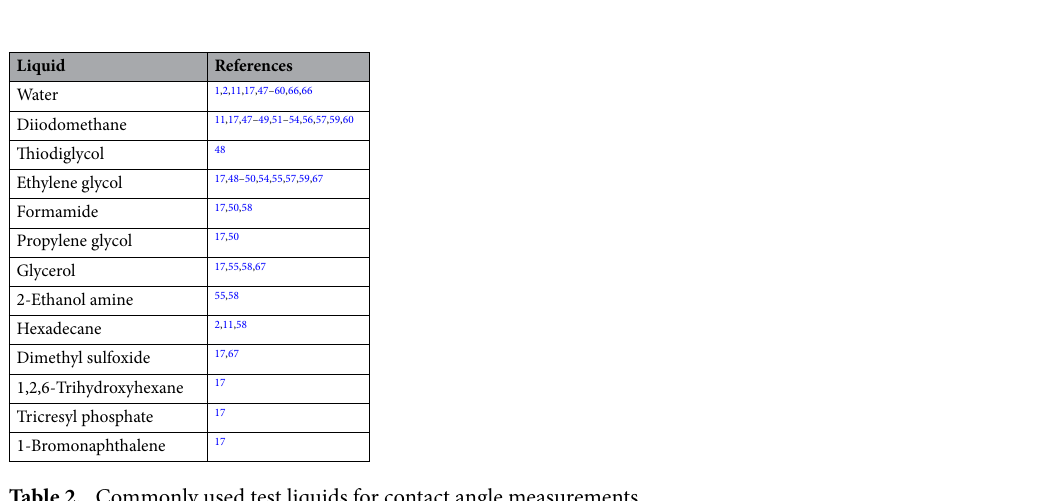
Table 2. Commonly used test liquids for contact angle